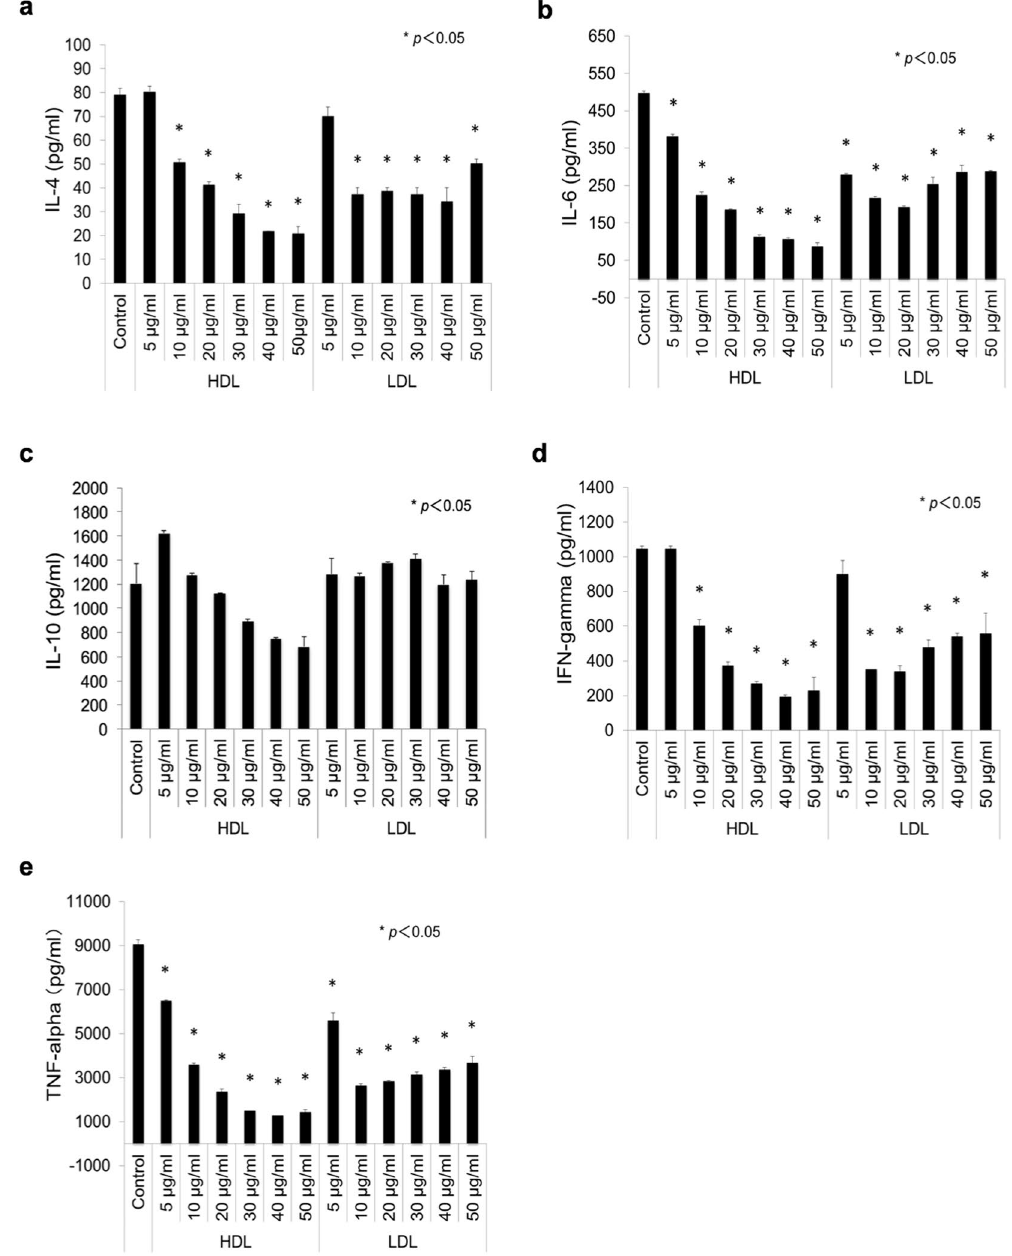
Figure 1. Effects of HDL and LDL on the expression of pro-inflammatory cytokines by M . tuberculosis -infected THP1macrophages. THP1-macrophages were cultured with or without adding HDL or LDL (5–50 µ g/ml) for 24 hours. The treated macrophages were then infected with M . tuberculosis (multiplicity of infection = 10) for 24 hours (n = 4). The amounts of IL-4 ( a ), IL-6 ( b ), IL-10 ( c ), IFN-gamma ( d ), and TNF- α ( e ) from macrophages were measured using the Bio-Plex Multiplex System. ANOVA was used for test the differences in